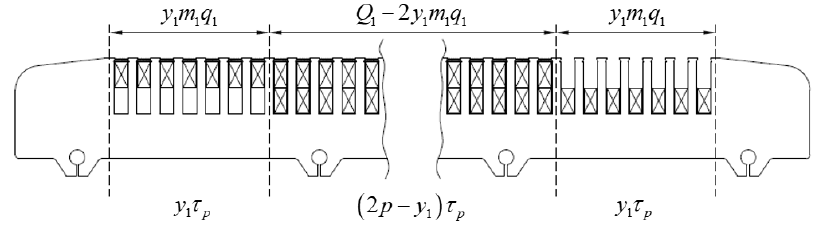
Figure 8. Slot number and lengths with half-filled slots, according to